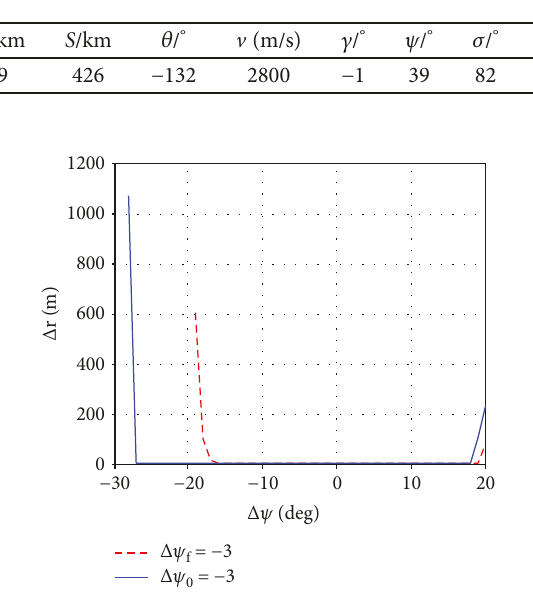
Figure 6: Curve of dropping error with Δ ψ